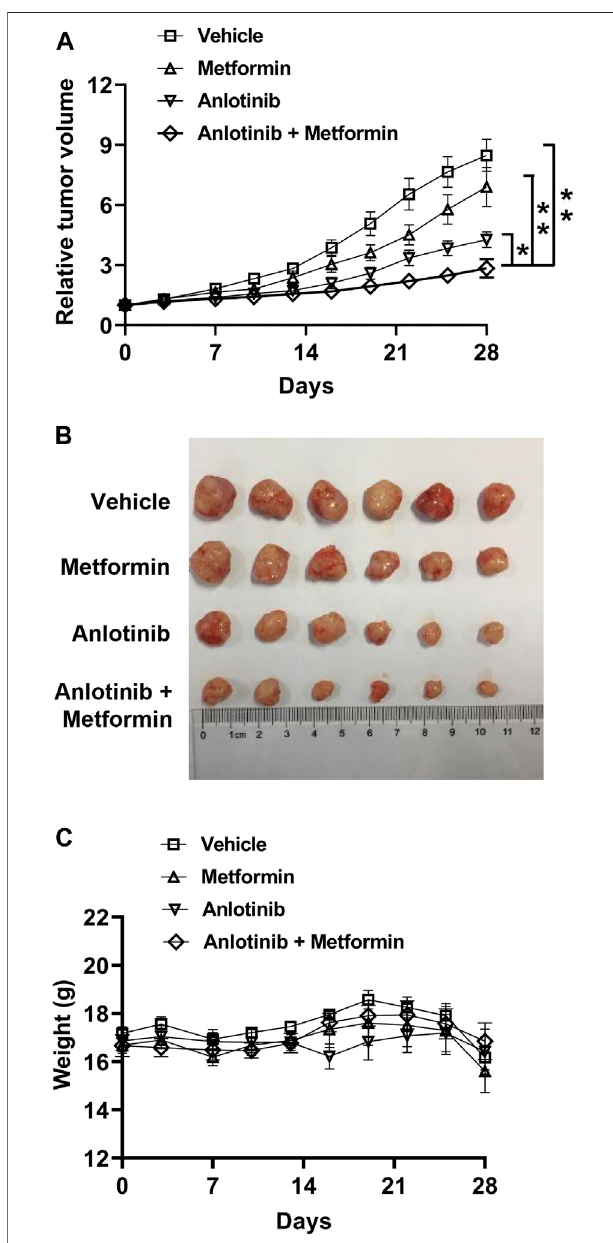
FIGURE2| Metforminpotentiatestheef fi cacyofanlotinibinaxenograftmodel (A) MicewithH460xenograftswererandomlydividedintofourgroupsandtreatedfor 28 consecutive days with vehicle (squares), anlotinib (triangles), metformin (inverted triangles), or both anlotinib and metformin (diamonds) as described in the Materials and Methods (B) The sizes of the xenografts at the end of experiment (C) Bodyweightwasmeasuredevery3 days.Dataarepresentedasmeans ± SE(n (cid:2) 6 per group). Statistical signi fi cance was analyzed using the unpaired Student ’ s t -test; * p < 0.05, ** p < 0.01.